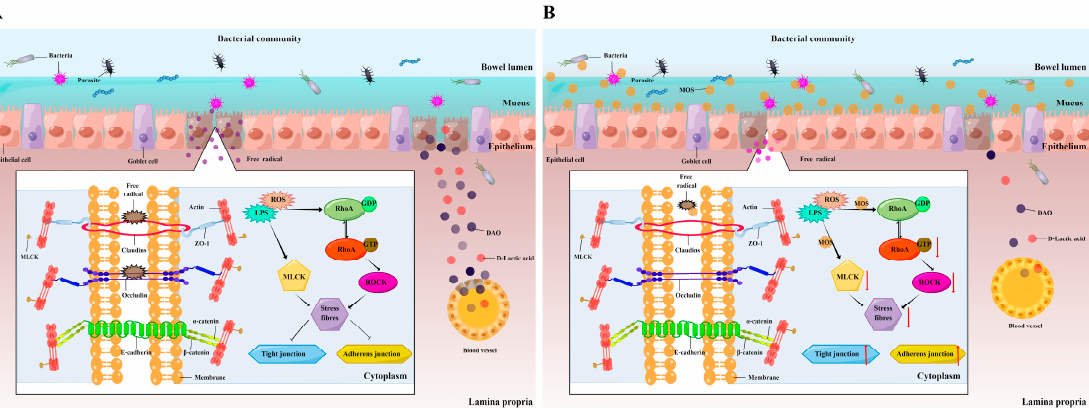
Figure 7. Potential action pathways of MOS on intestinal structural integrity and its related mech- anisms after infection with Aeromonas hydrophila . ( A ) A. hydrophila group; ( B ) optimal MOS group. This picture is drawn by Figdraw (www.figdraw.com, accessed on 24 March